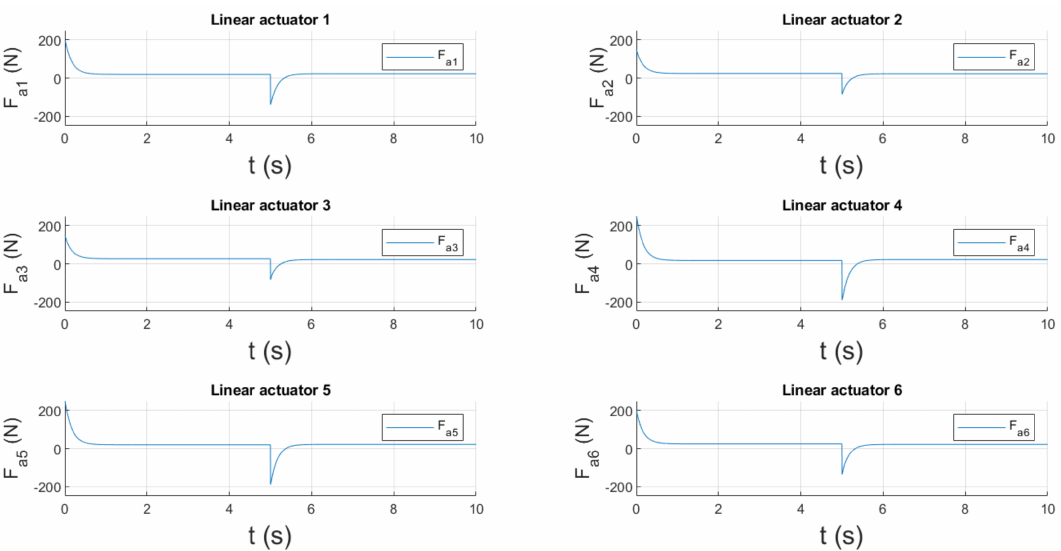
Figure 10. Acting forces of the Stewart platform linear actuators